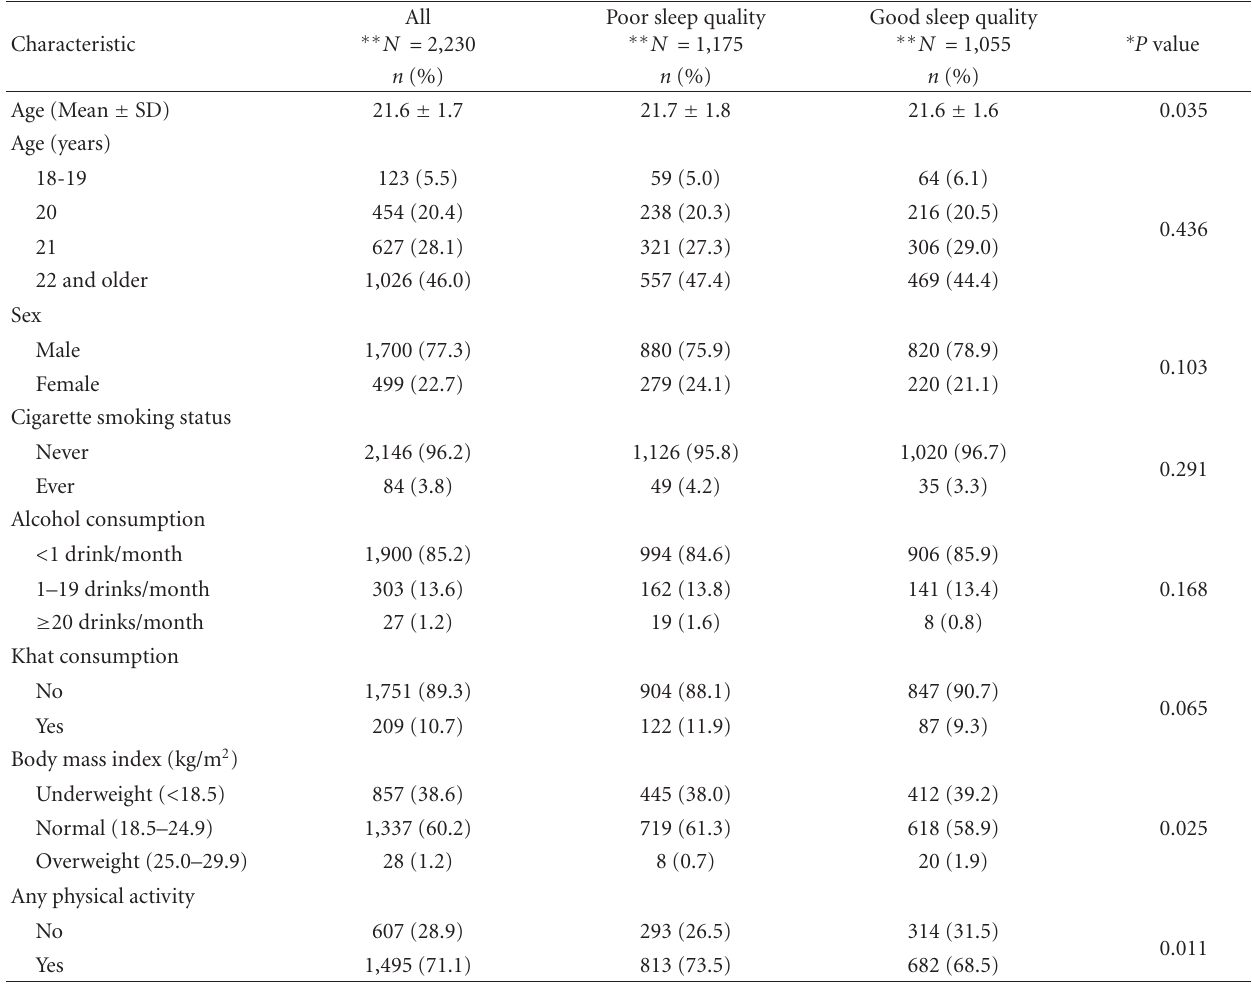
Table 1: Characteristics of the study population.